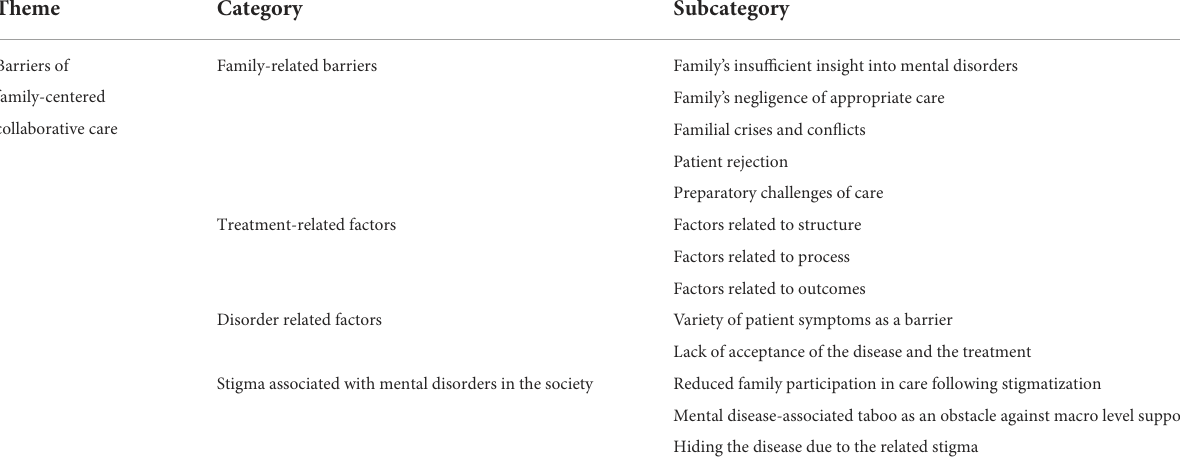
TABLE 2 Summary of study